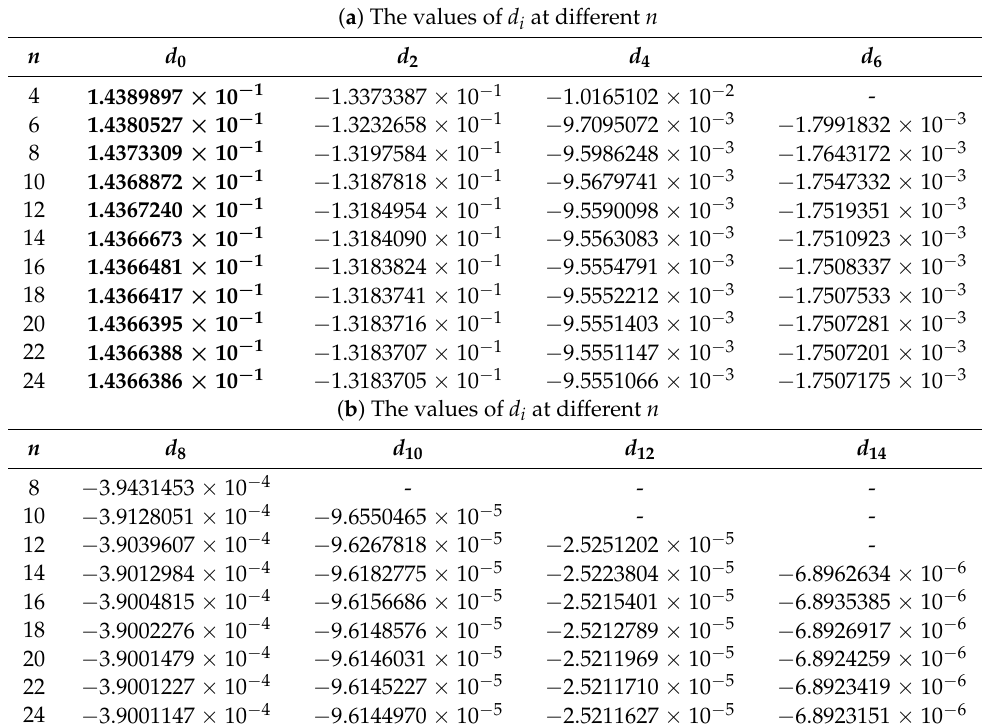
Table 3. ( a ) The values of d i at different n ; ( b ) The values of d i at different n ; ( c ) The values of d i at different n ; ( d ) The value of d 24 at n =